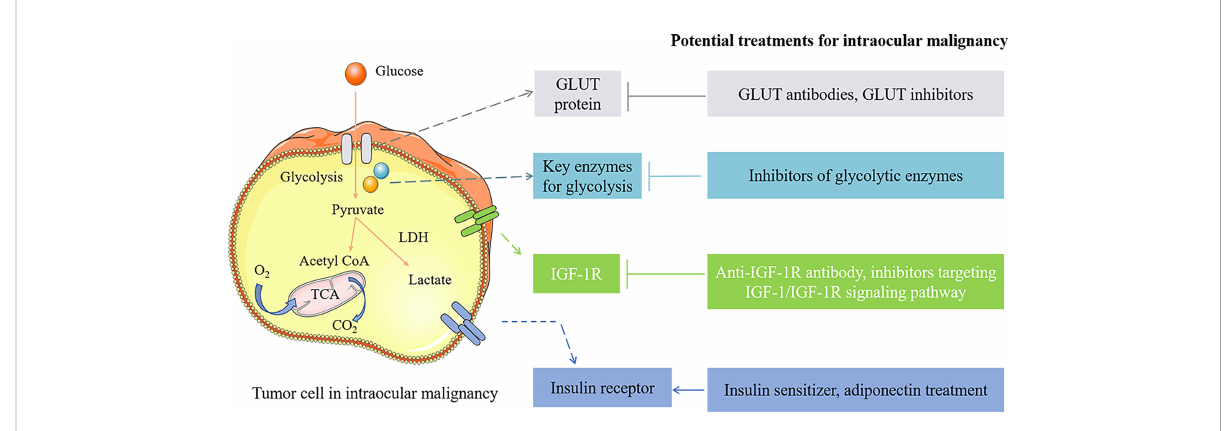
FIGURE 2 The potential treatments for intraocular malignancy by intervening the pathogenic factors of diabetes. GLUT1 inhibitors as well as GLUT1 antibodies inhibit tumor cell growth by limiting glucose translocated into the cell. Treatments targeting glycolytic enzymes inhibit glucose metabolism and tumorigenesis, including miR-216a-5p (the HK2 inhibitor), SOX-10 knockdown (GAPDHS suppression), and 2-DG and 2-FG (glycolytic inhibitors). Anti-IGF-1R antibody, IGF-1R inhibitor (such as pristimerin), PI3K/AKT inhibitors, FoxO3a overexpression, and miR-98 upregulation exert antitumor function by limiting IGF-1R and IGF-1/IGF-1R signaling pathway. Insulin sensitizer (such as metformin) and adiponectin treatment are considered potential approaches for treating intraocular malignancies by improving insulin resistance. ! , activation; ⊥ ,